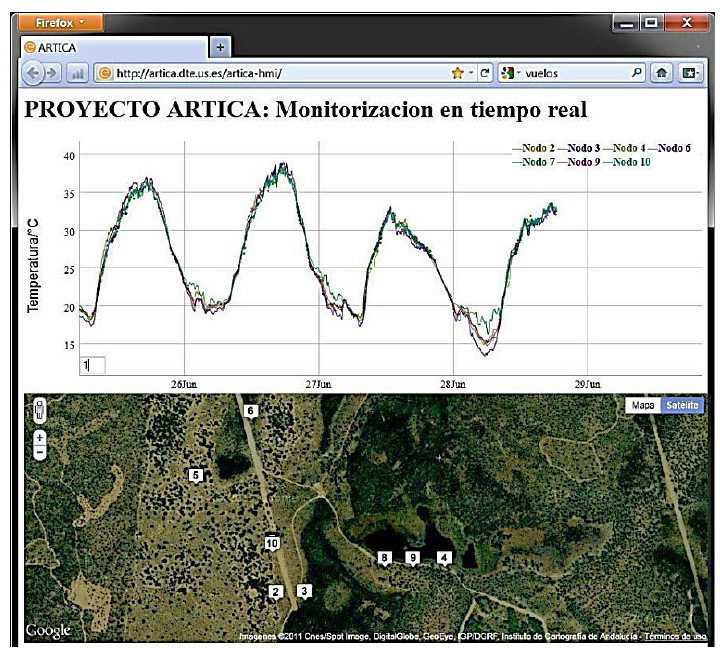
Figure 4. Access GUI to ARTICAs